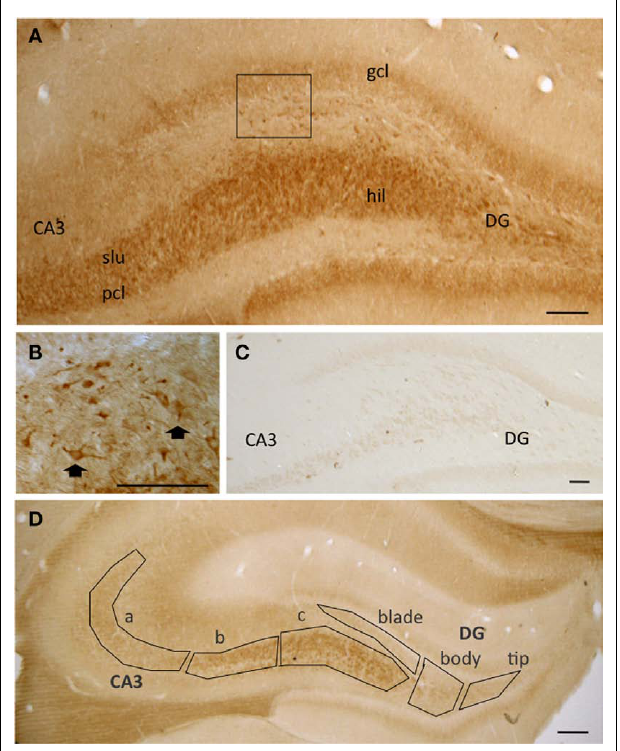
FIGURE 1 | (A) At the light level, pMOR-immunoreactivity (pMOR-ir) is most dense in stratum lucidum (slu) of CA3 and in the hilus (hil) of the dentate gyrus (DG). (B) Higher magnification of the inset in A shows that several cells contain pMOR-ir in the dorsal hilus (arrows). (C) No labeling was seen in these regions following preadsorption of the pMOR antibody with antigenic peptide. (D) The mossy fiber pathway zone was divided into six regions for analysis: CA3a, CA3b, and CA3c and the denate gyrus tip, blade, and body. gcl, granule cell layer; pcl pyramidal cell layer. Scale bars = 100 μ m.